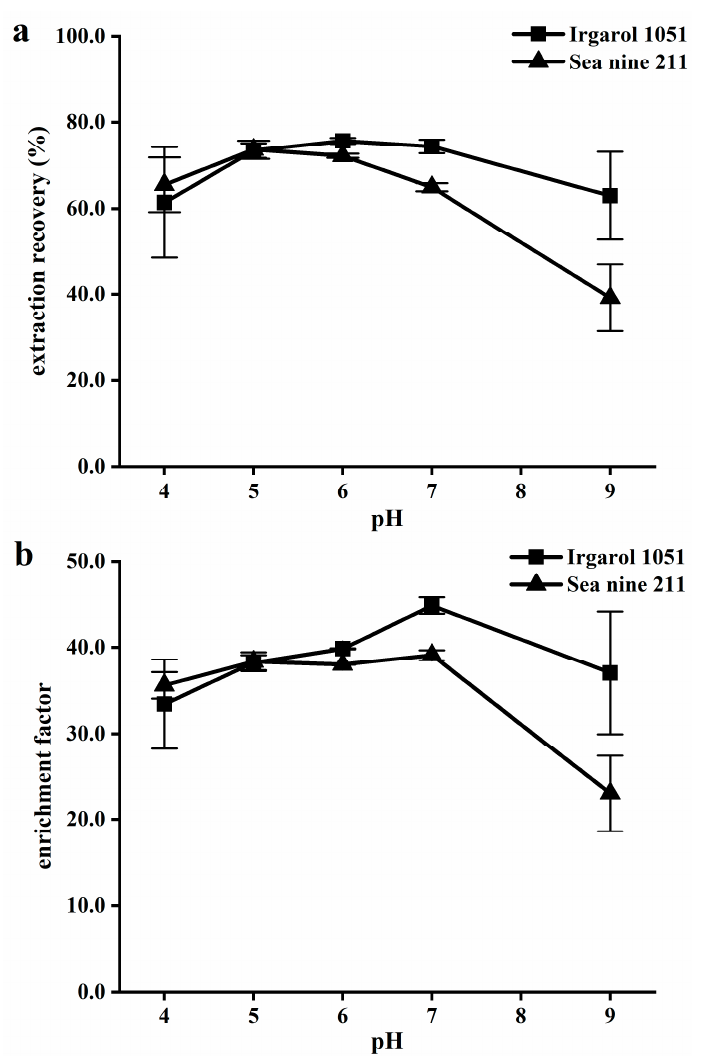
Figure 4. Influence of pH on ( a ) extraction recovery and ( b ) enrichment factor. Extraction conditions: water sample, 5.0 mL; disperser solvent, ethyl acetate 0.4 mL; extraction solvent [HMIm][PF6] 60 mg; NaCl 0% ( w / v ); and cooling temperature 20 °C .